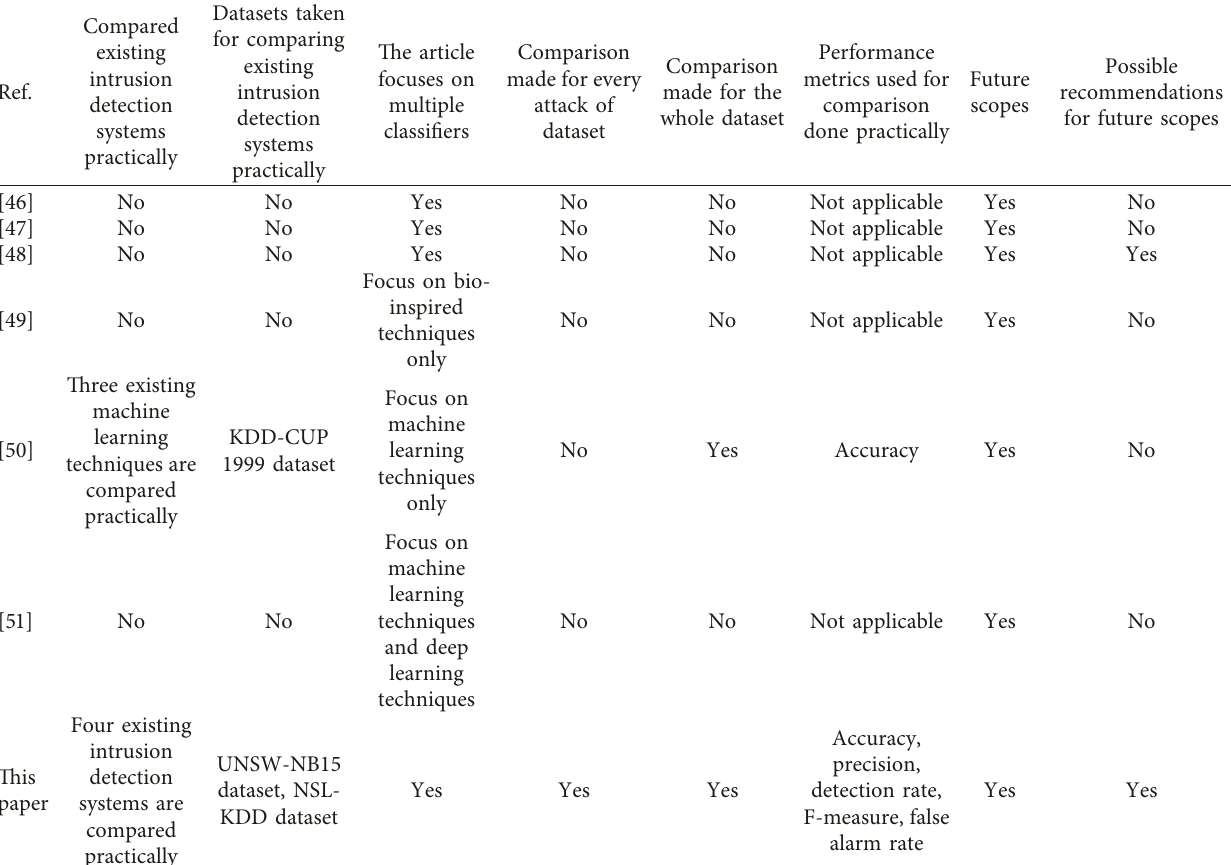
Table 2: Comparison of our survey article with other survey